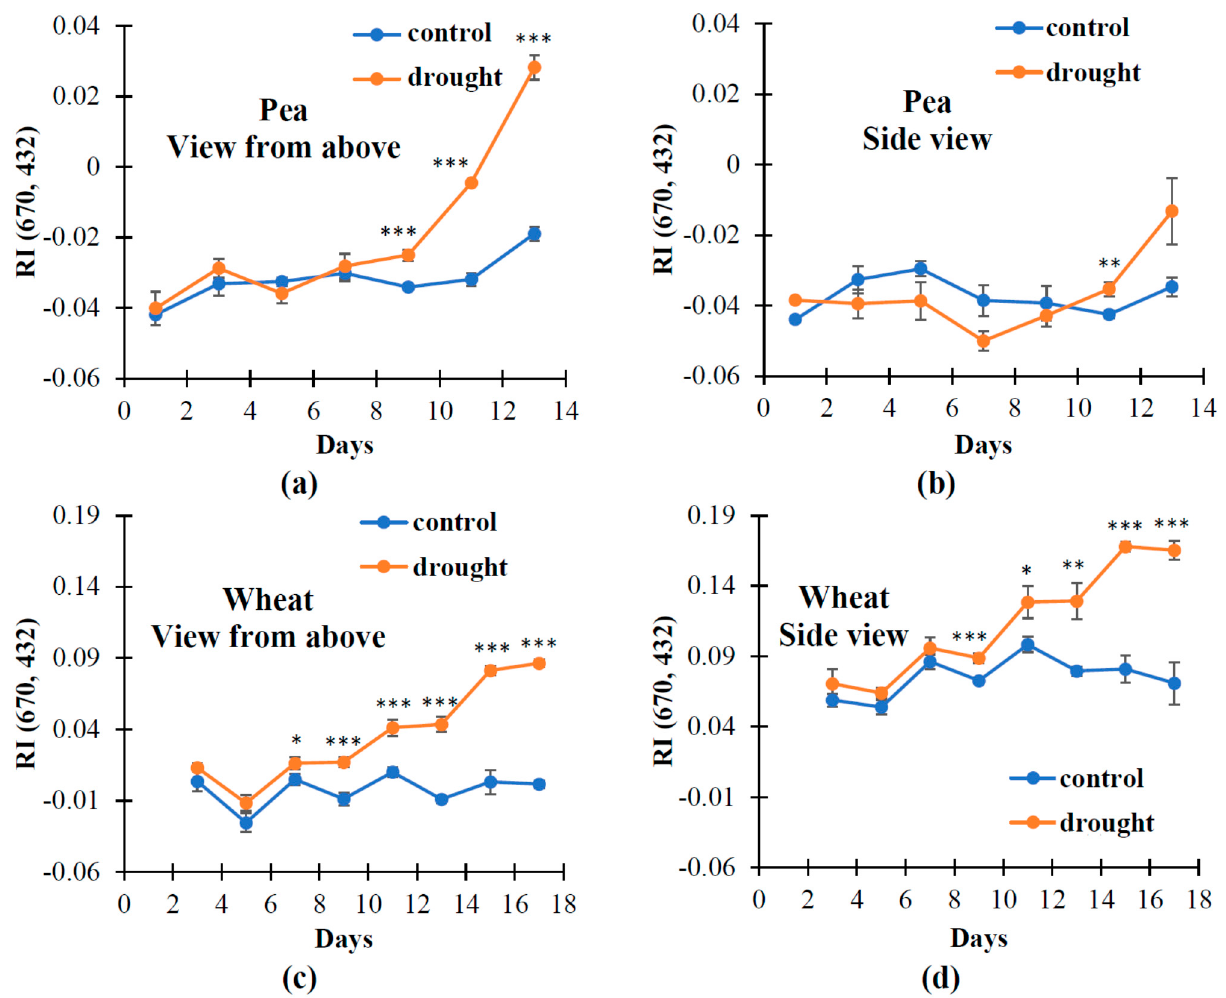
Figure 5. The influence of the soil drought on RI (670, 432) in pea and wheat cultivated under controlled conditions. ( a ) The measurement of RI (670, 432) in pea from the view from above; ( b ) the measurement of RI (670, 432) in pea from the side view; ( c ) the measurement of RI (670, 432) in wheat from the view from above; ( d ) the measurement of RI (670, 432) in wheat from the side view. * p < 0.05; ** p < 0.01; *** p < 0.001.